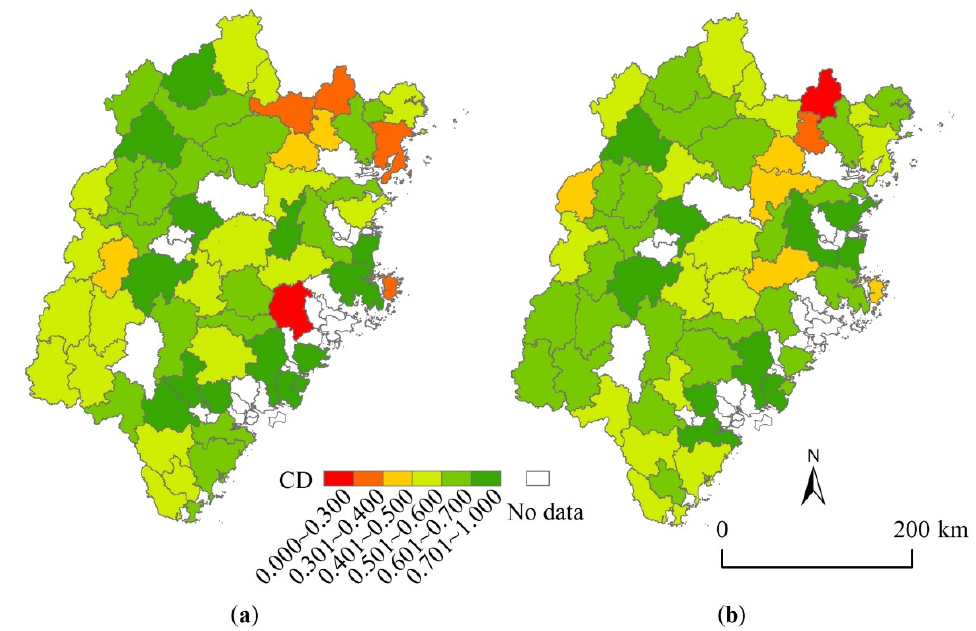
Figure 7. Coordination degree of EI and EC and TR in Fujian province in 2000 and 2018. ( a ) Coordination degree of EI & EC & TR in 2000; ( b ) Coordination degree of EI & EC & TR in 2018.